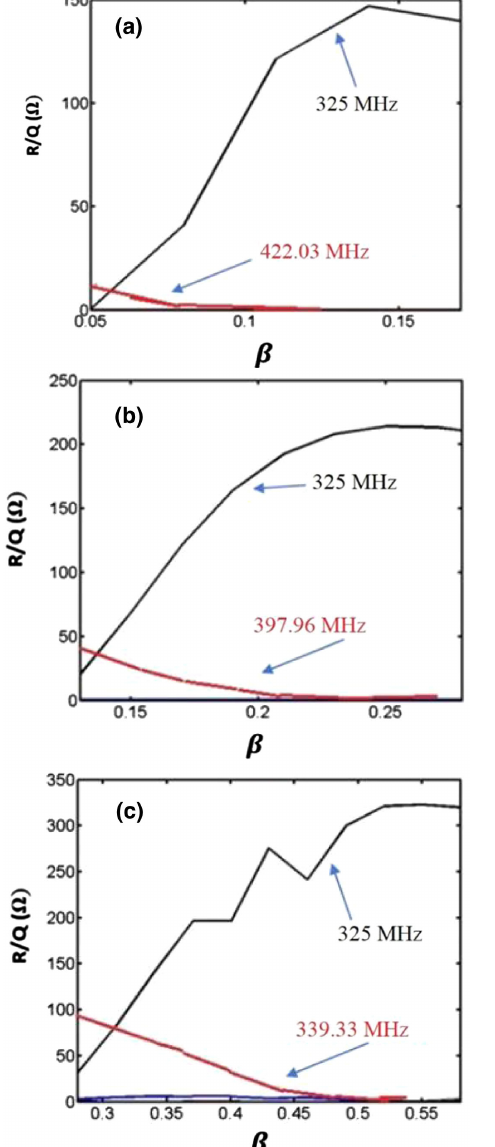
FIG. 21. Monopole modes R/Q for the (a) SSR-A, (b) SSR-B, and (c) SSR-C, cavities.